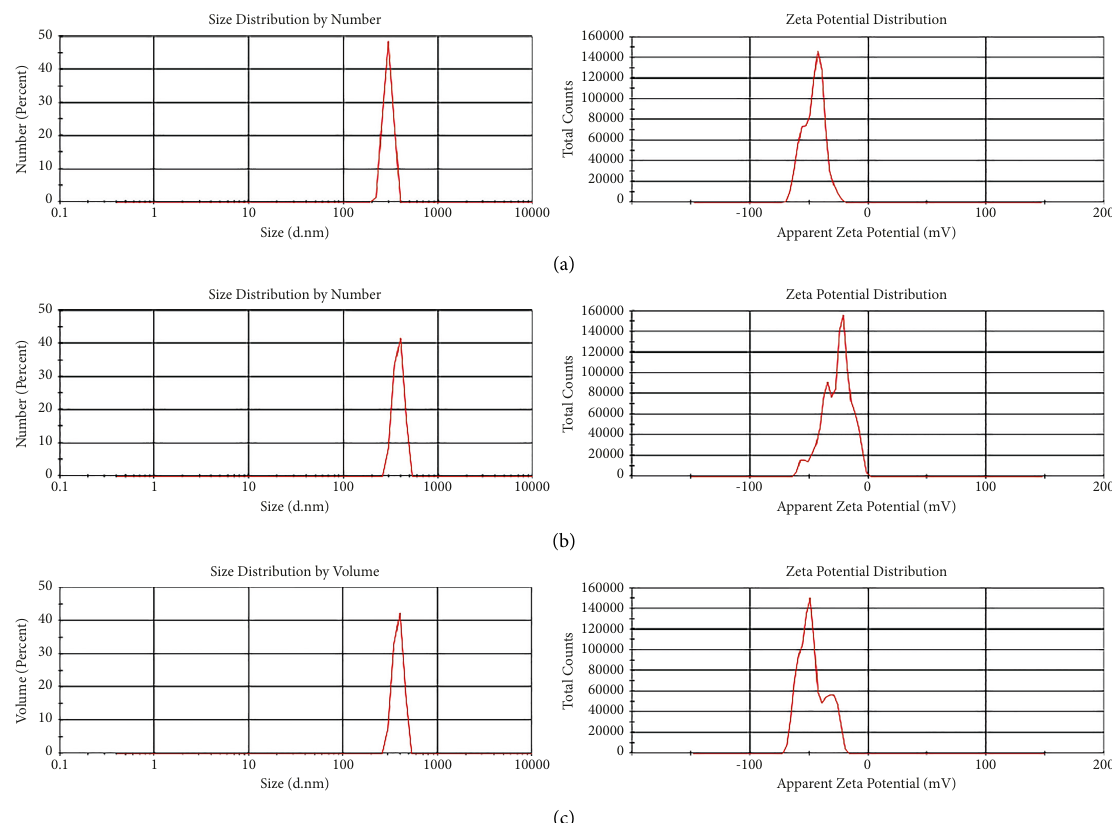
Figure 7: DLS analysis and zeta potential of (a) ZnO/4A, (b) TiO